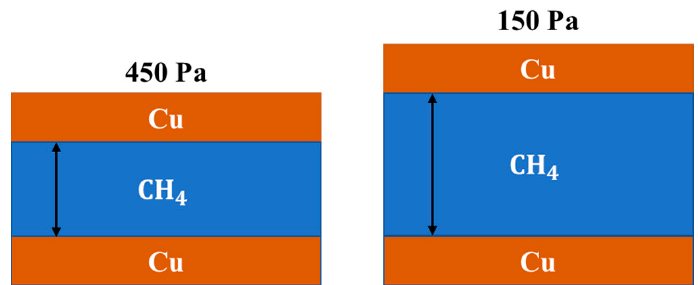
Figure 7. Variation in methane content with the growth pressure in copper pockets.